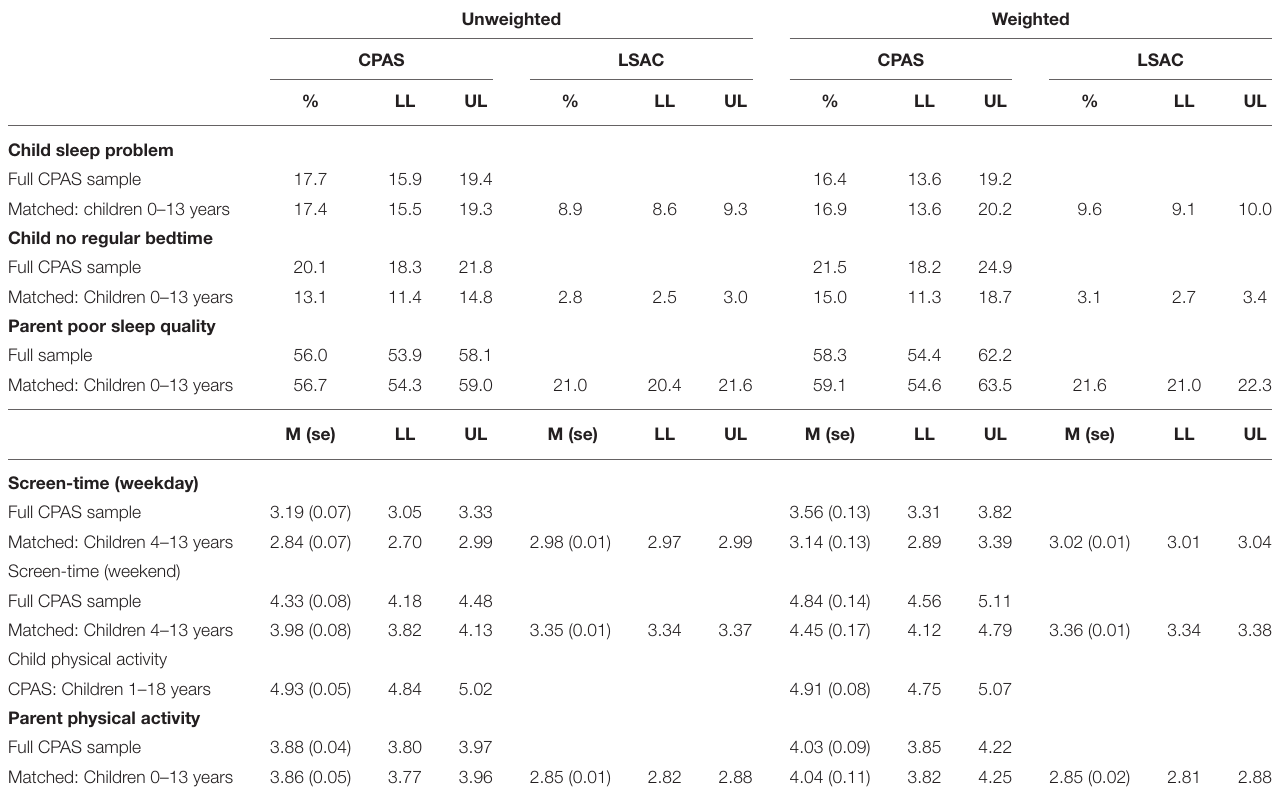
TABLE 3 | Parent and child physical activity, sleep, and screen time compared to Australian normative data (LSAC). Unweighted Weighted CPAS LSAC CPAS